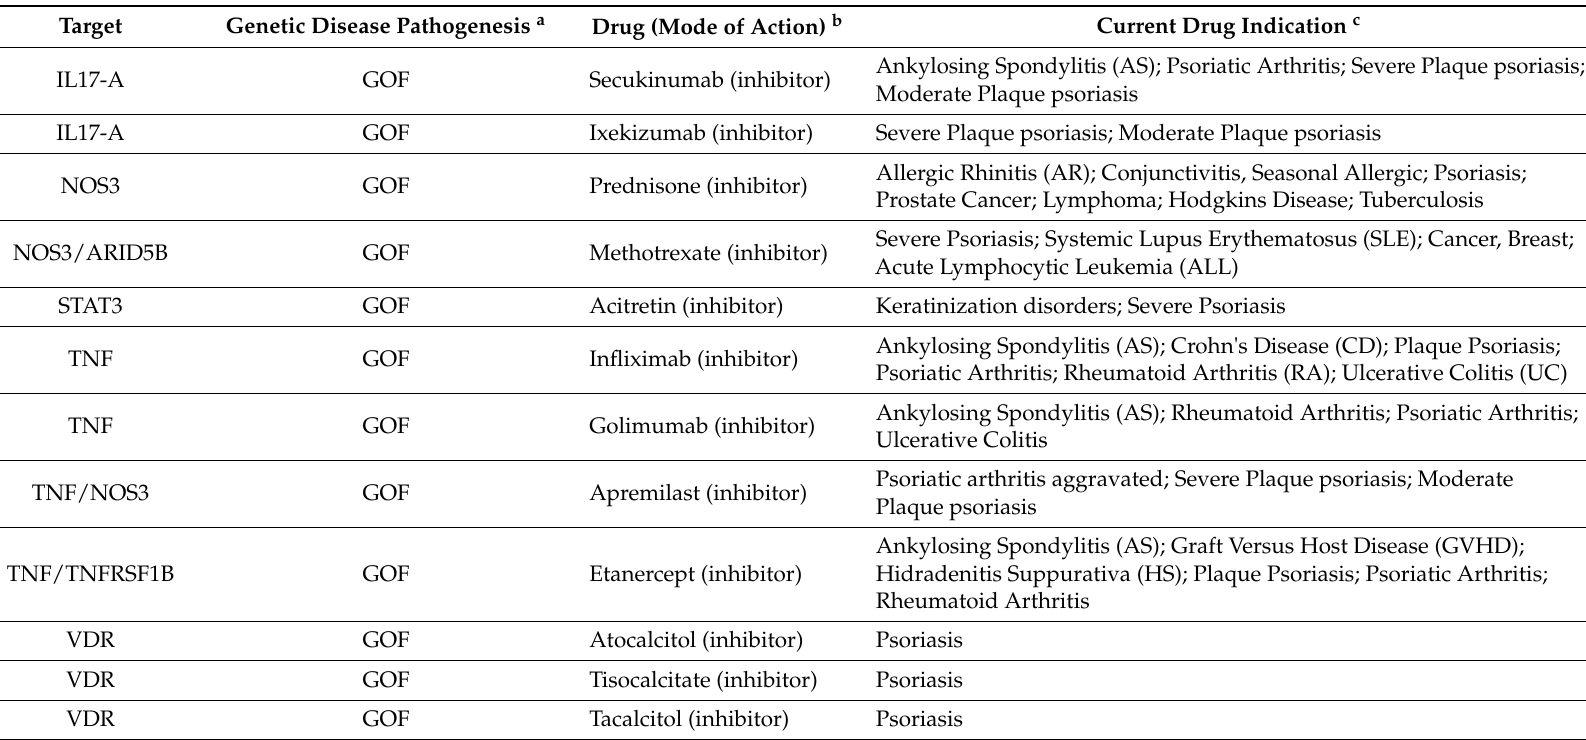
Table 2. Anti-psoriasis drugs and their medical genetics of